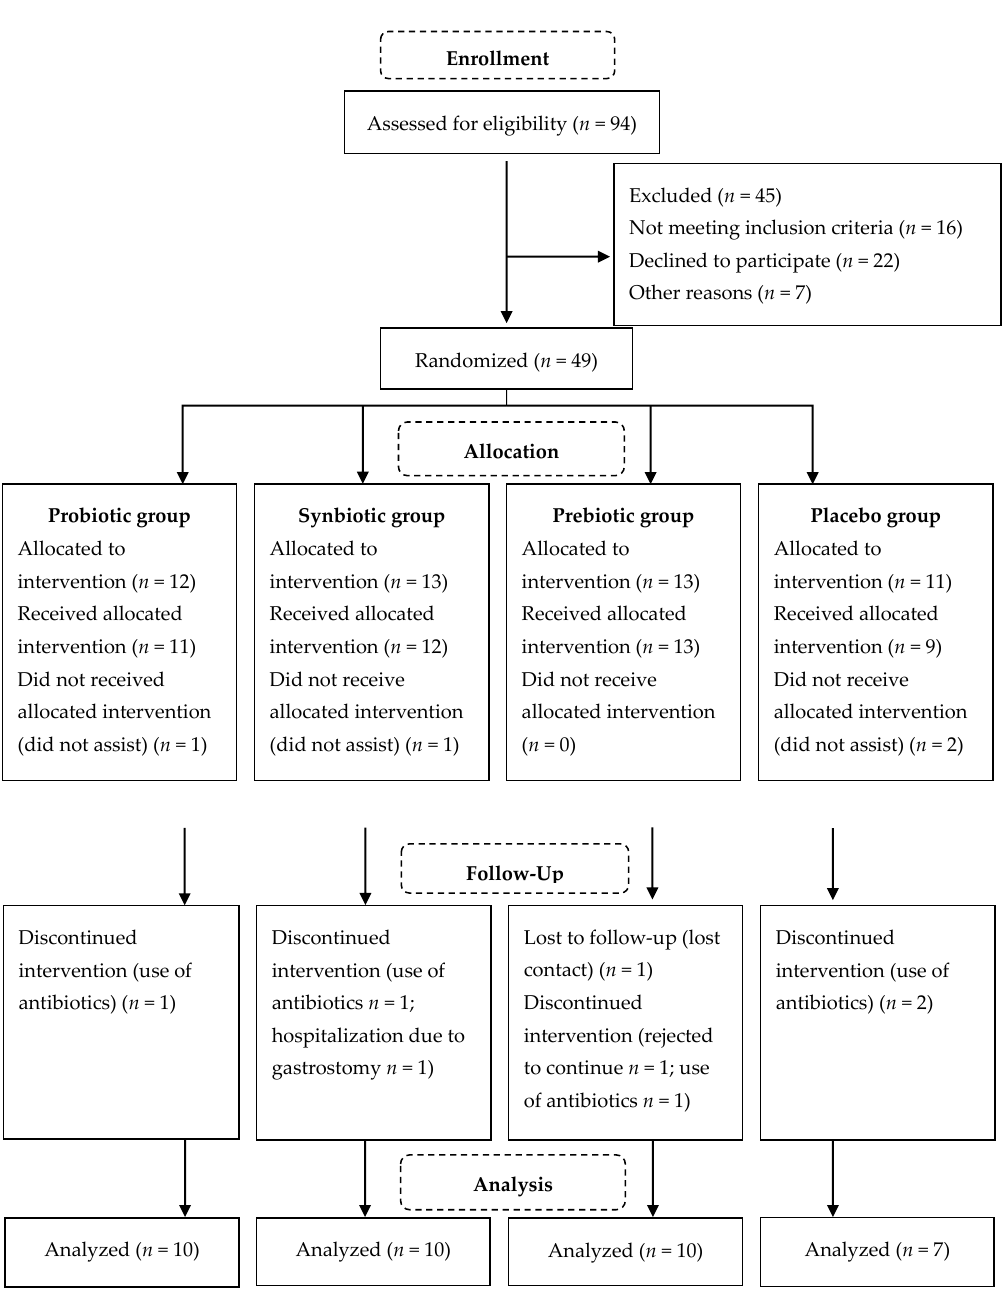
Figure 1. CONSORT flowchart of participant recruitment and study flow. Table 1. Baseline characteristics of the study population.